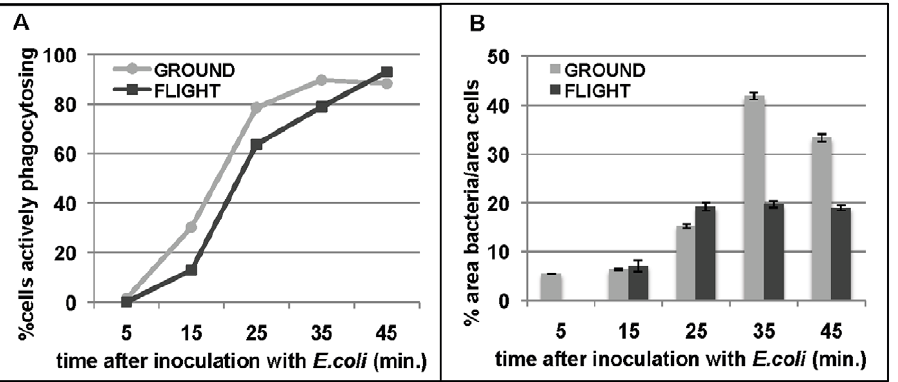
Figure 2. Spaceflight alters phagocytosis. A. The number of actively phagocytosing cells is reduced by spaceflight. At 15, 25, and 35 minutes, a significantly lower number of cells engulfed E. coli in hemocyte cultures from spaceflight larvae. The calculated p -values were 0.32, 2.16E-07, 3.38E-05, 3.86E-08, and 5.8E-04 for the 5, 15, 25, 35 and 45-minute time points respectively. The data points are tight and give calculated standard error values in the 10 2 2 range, not visible on the graph. B. The phagocytic capacity of larval plasmatocytes is stunted. The number of Alexa594-labeled E. coli engulfed by larval plasmatocytes in culture was compared in samples from flight and ground up to 45 minutes after infection. Cells from both space- and ground-reared larvae had similar levels of activity up to 25 minutes post-infection, while after 35 minutes space larvae plasmatocytes had significantly reduced phagocytic capacity. doi:10.1371/journal.pone.0015361.g002 source of mature lamellocytes released into circulation upon We analyzed the expression of markers associated with the infection [47]. The specification and maturation of hemocytes are stages of hemocyte development and maturation at the 3 rd instar determined during development by the expression of markers and compared their expression level during spaceflight with that of particular to each cell lineage. ground controls. We found that only the markers of mature